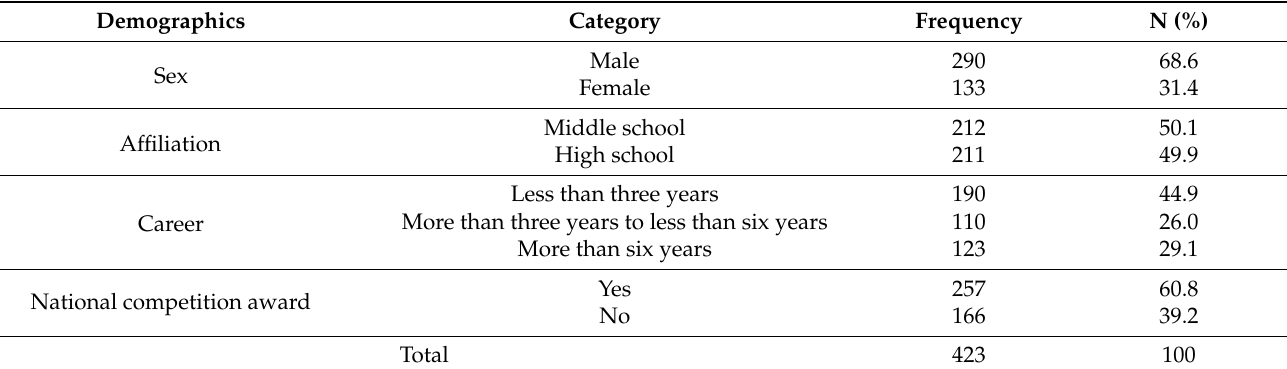
Table 1. Characteristics of the